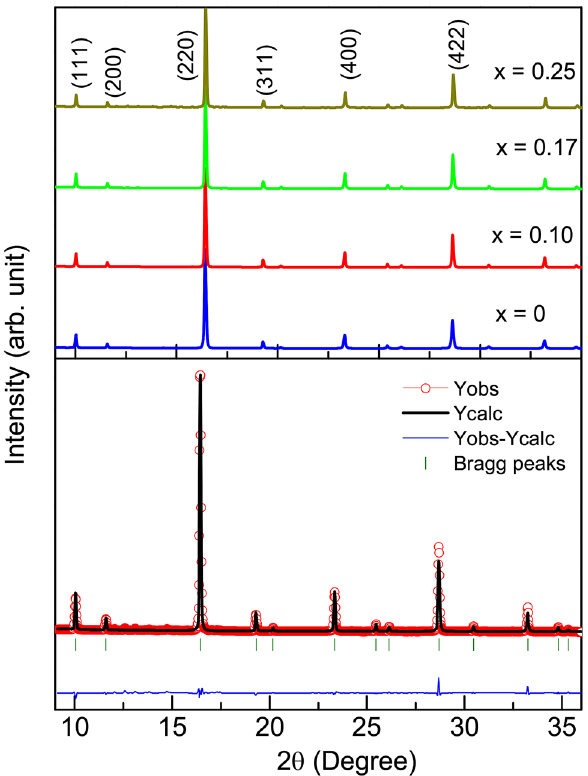
(cid:31) = 0.612 Å). The